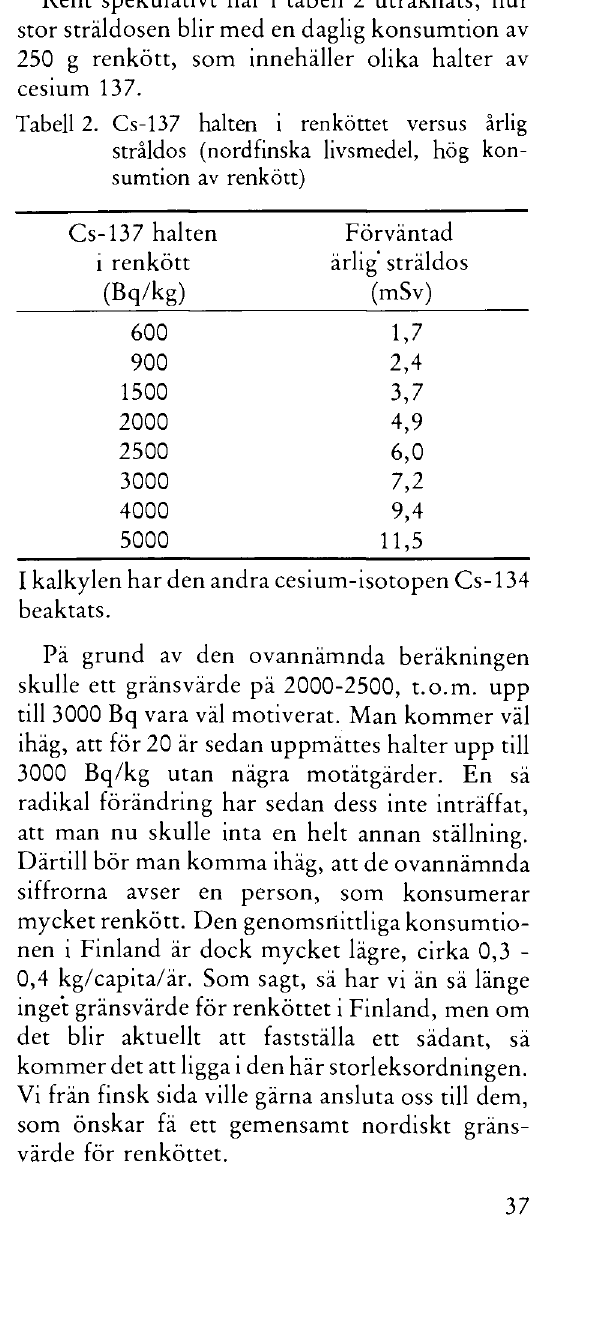
Tabell 2. Cs-137 halten i renköttet versus